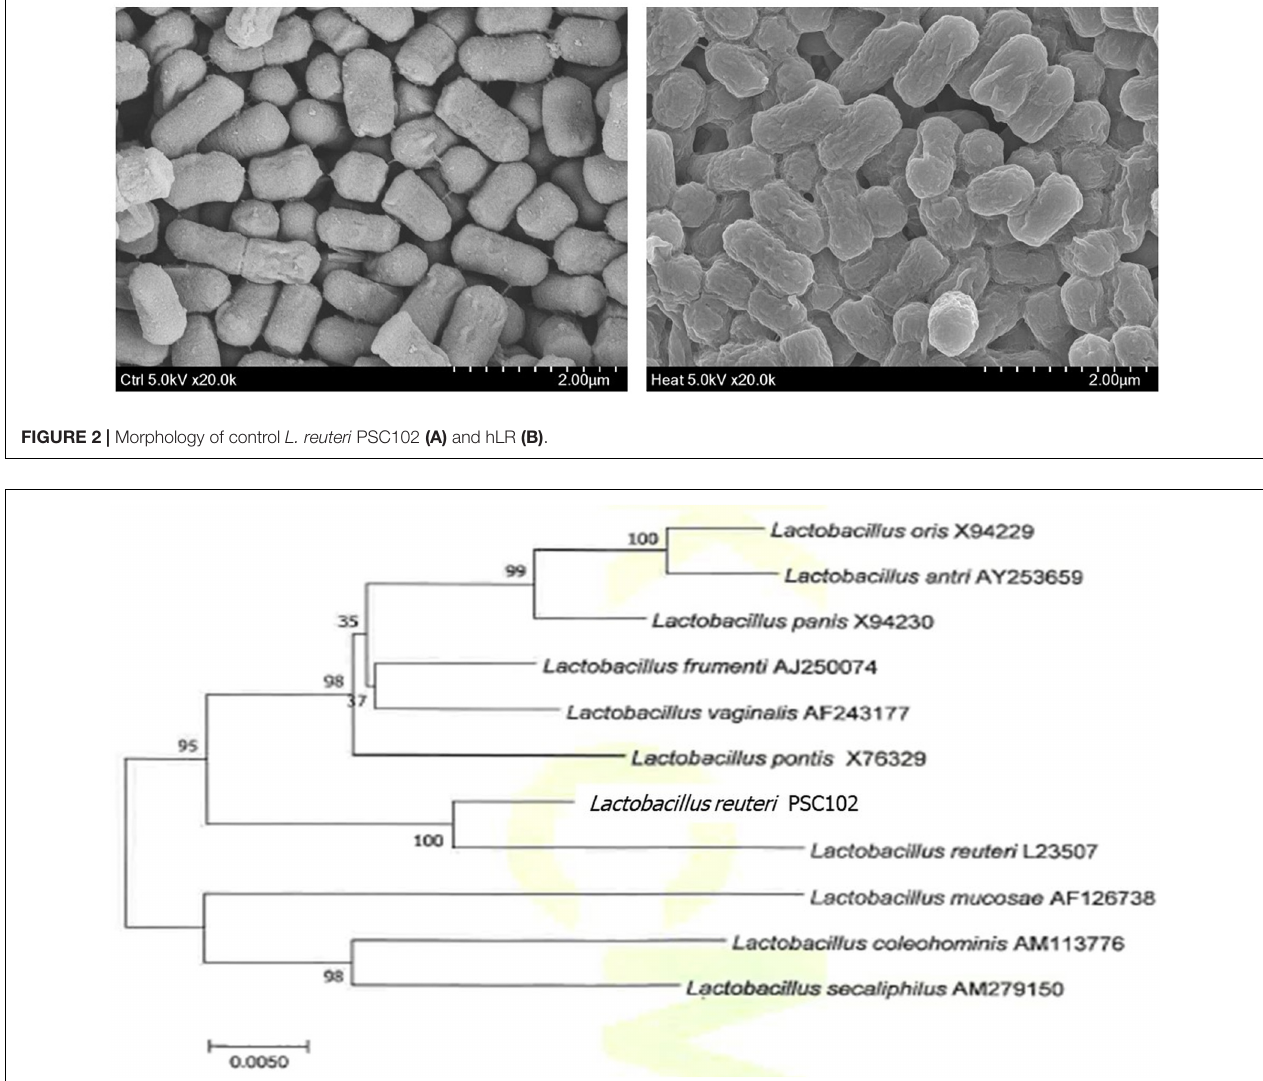
FIGURE 3 | Phylogenetic tree of strain L. reuteri PSC102 based on the comparative analysis of the 16S rRNA sequence. Data were obtained from the NCBI-GenBank, and the phylogenetic tree was built with the neighbor-joining method using the Mega 5.0 program package. Scale bar, 0.0050 substitution per